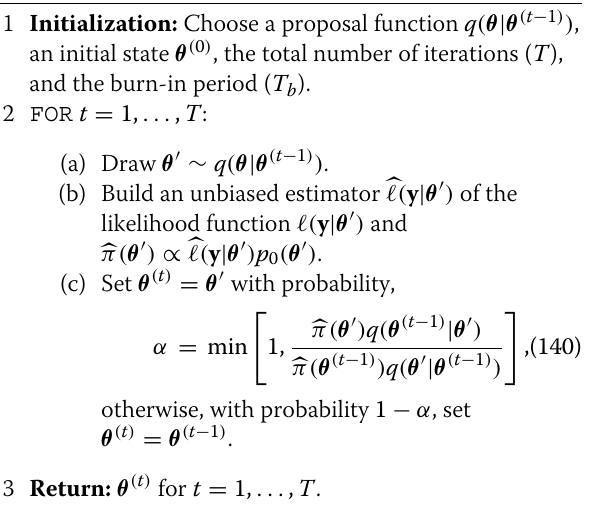
Algorithm 29 Generic Pseudo-Marginal MH